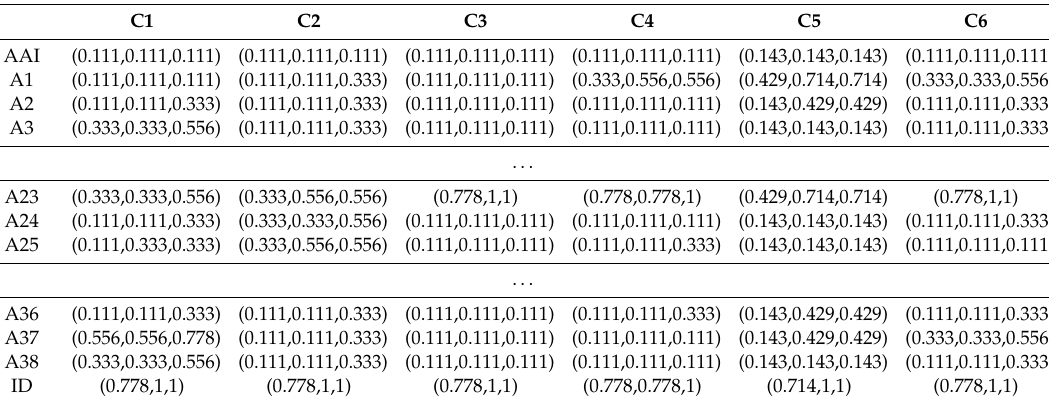
Table 4. Fuzzy normalized decision matrix.